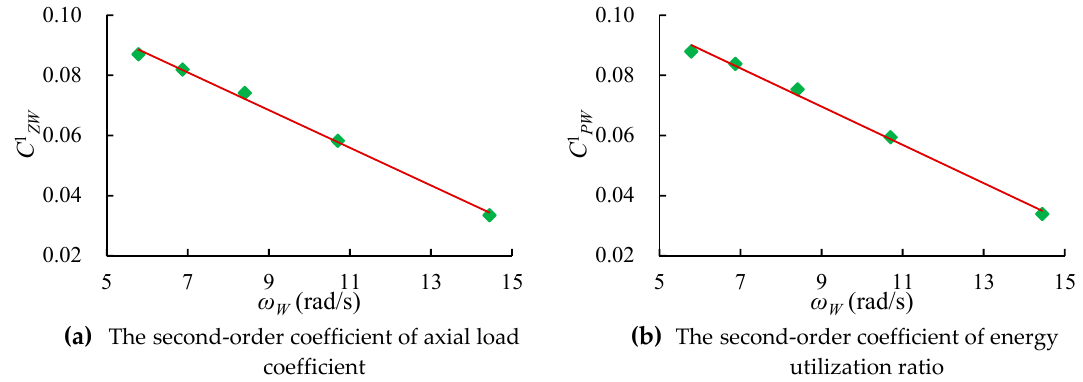
Figure 10. The first-order coefficient ( 1